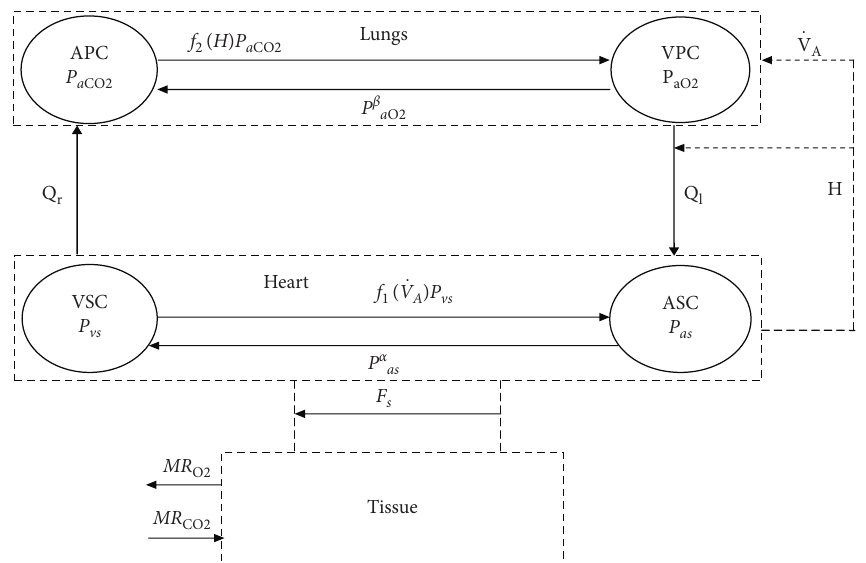
and MR represent the metabolic oxygen consumption rate O 2 CO 2